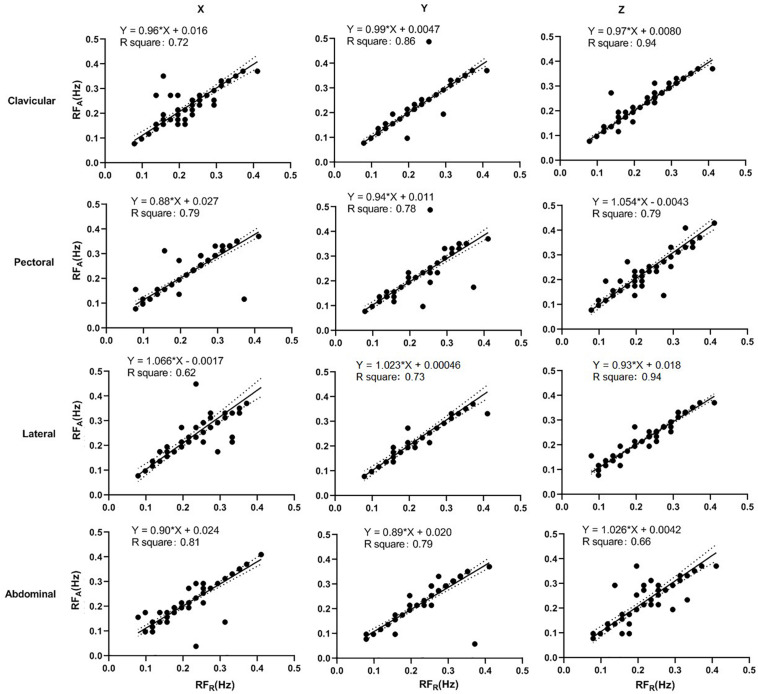
Linear regression of the accelerometer-derived and reference RFs in supine posture. The x- and y-axes denote the reference and accelerometer-derived RFs, respectively. The points mark the measured data. The solid and dotted lines indicate the best-fit line and its 95% confidence interval, respectively.